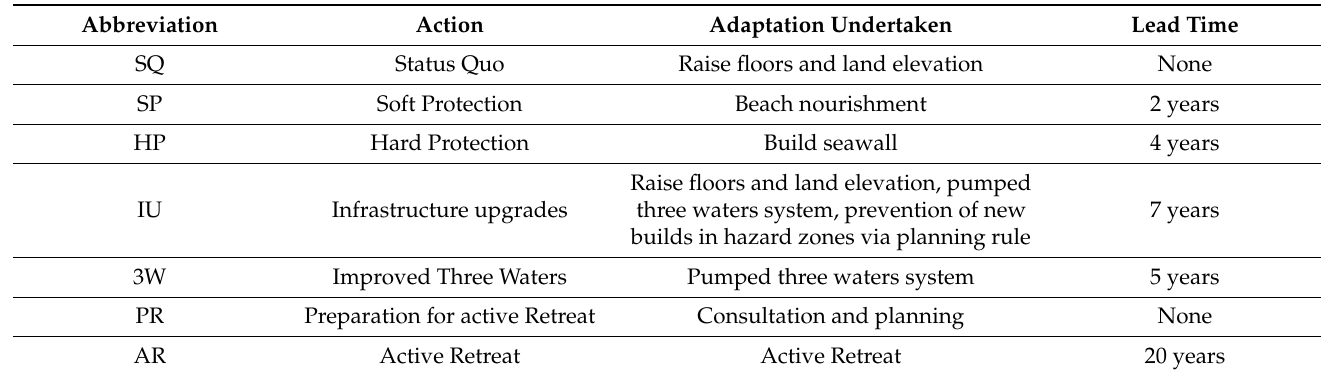
Table 2. Actions represented in MHCABM. The default initial action is raising floors and land eleva- tion of a building to remove it from the coastal hazard zone as defined by the New Zealand Building Act [56]. Preparation for active retreat has no lead time as the preparation begins immediately, with a 20-year window before Active Retreat begins. During Preparation for active retreat agents respond to hazards via the action selected by the previous